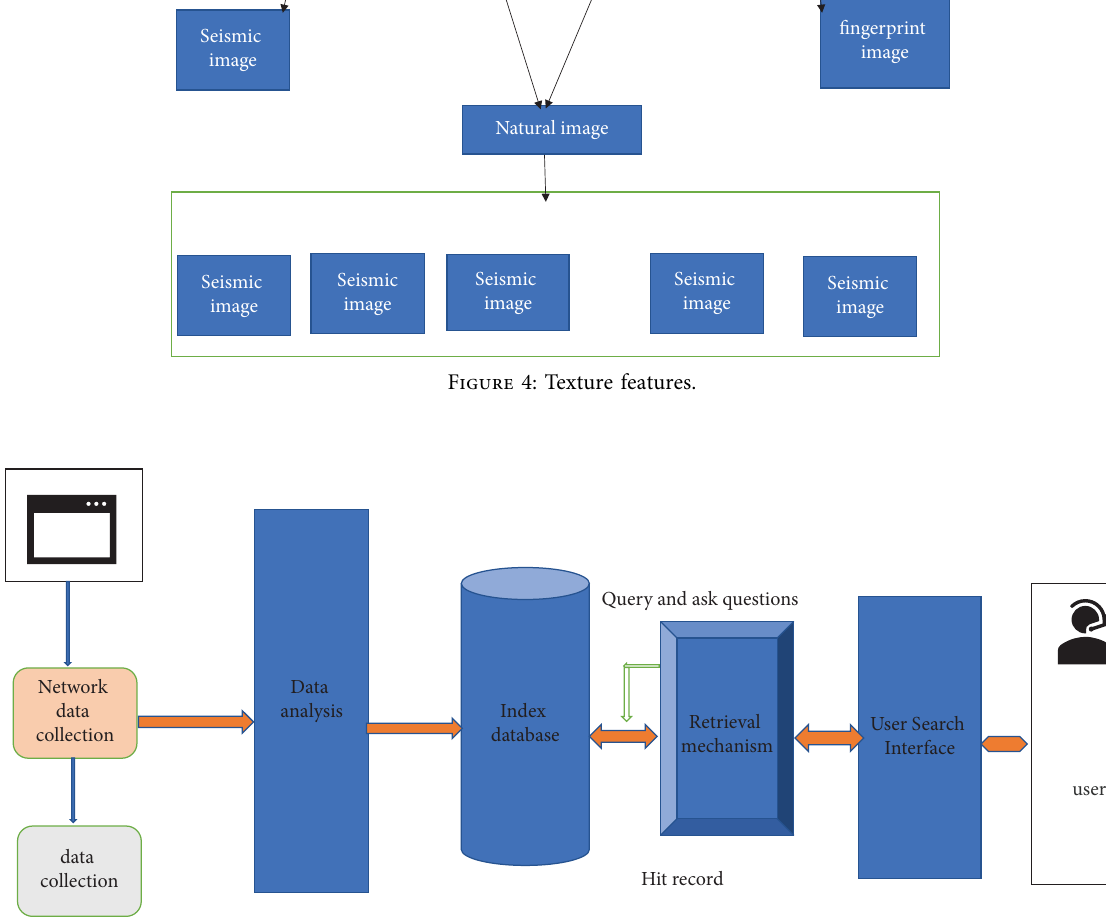
Figure 5: Flowchart of image